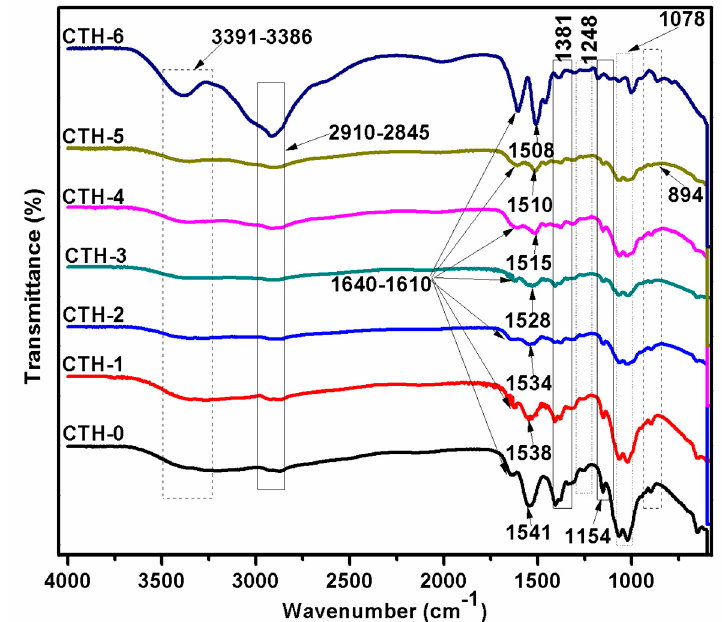
Figure 2. ATR-FTIR spectra of chitosan (CTH-0), PAH (CTH-6), and their blend films showing different chitosan/PAH compositions—100/0 (CTH-0), 80/10 (CTH-2), 60/40 (CTH-4), and 40/60 (CTH-5).